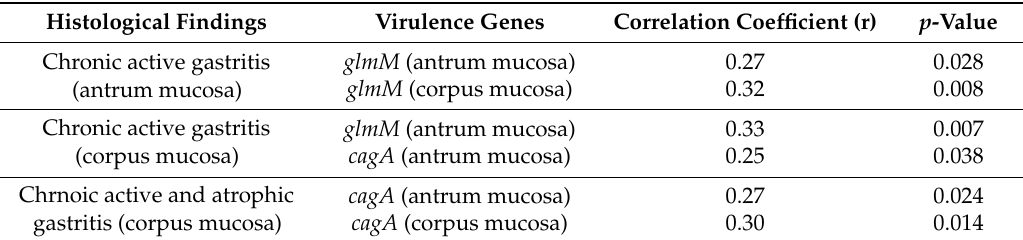
Table 4. Correlations between histological findings and present virulence genes.